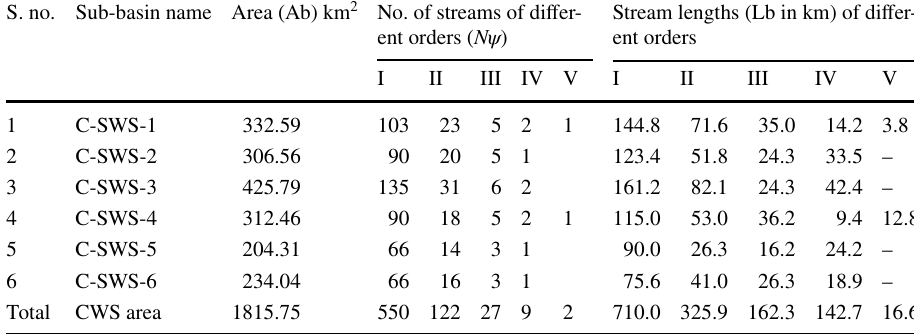
Table 2 Number of streams and stream lengths of Champua sub-watershed of Baitarani river